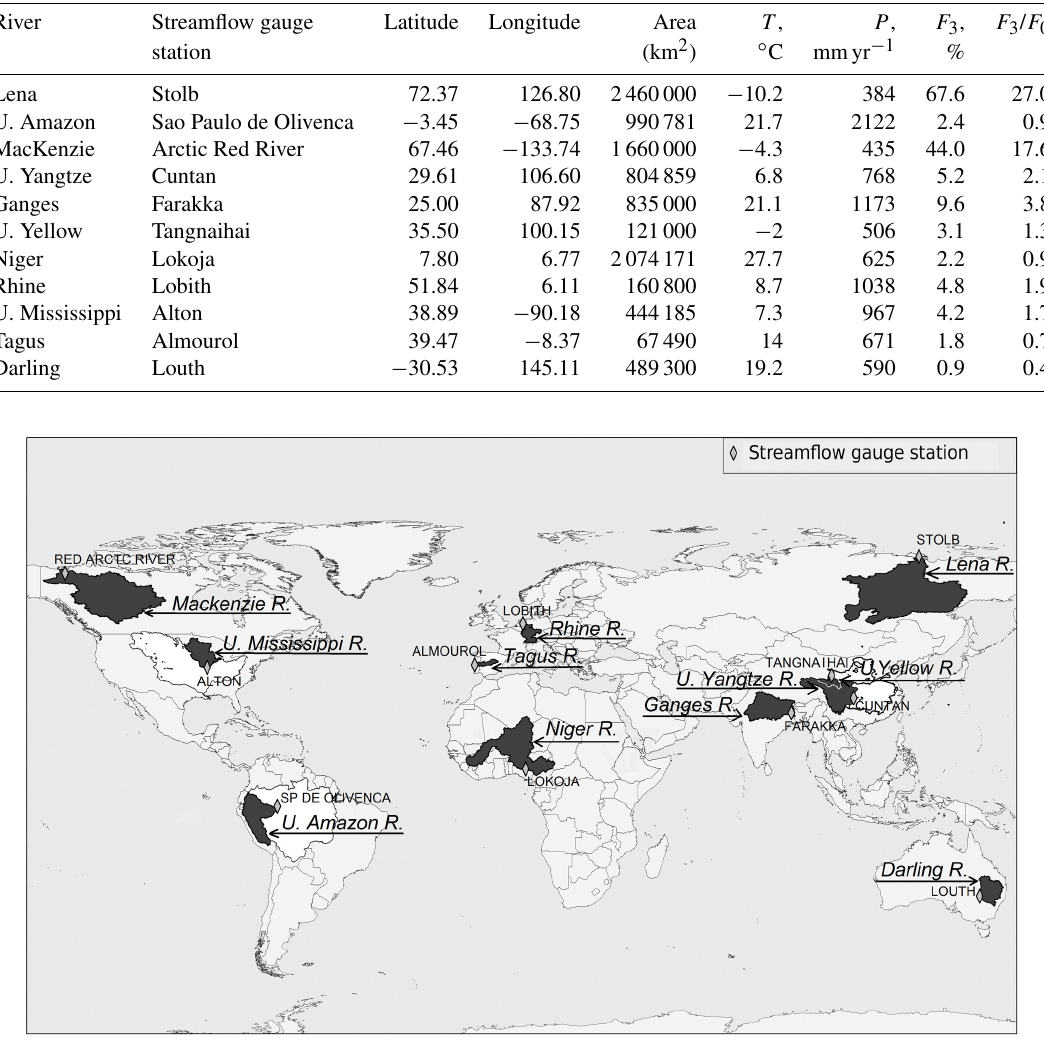
Figure 1. Location of the selected river basins (Gusev et al.,